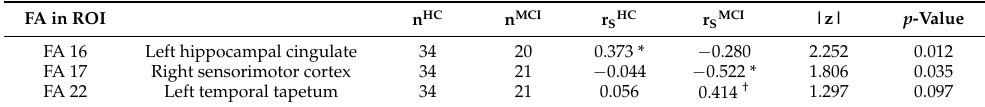
Table 5. Significant correlations between fractional anisotrophy (FA) and MoCA scores in older healthy controls (HC) and older adults with mild cognitive impairment